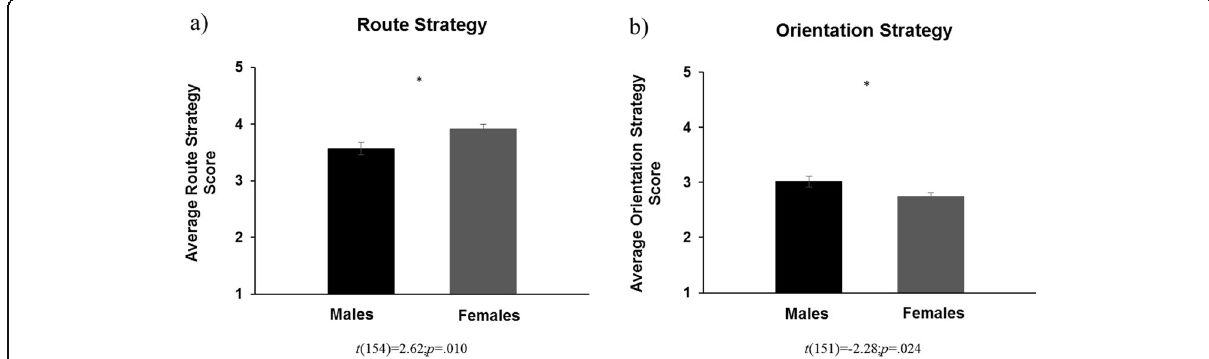
Fig. 2 Sex difference in route strategy ( a ) and orientation strategy ( b ) use. * p <